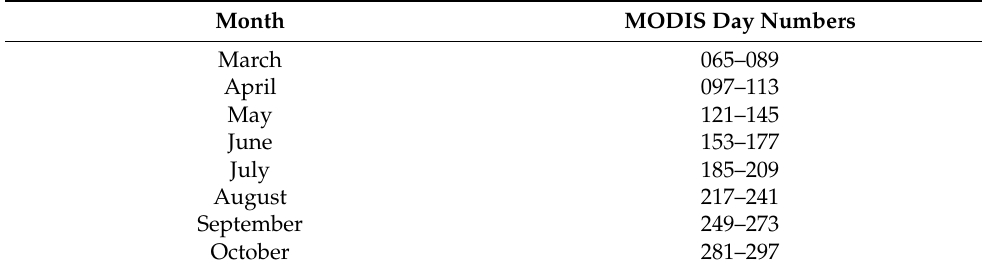
Table 1. Monthly subdivision of Moderate Resolution Imaging Spectroradiometer (MODIS) day numbers for pixel-based monthly correlation analysis between NDVI and